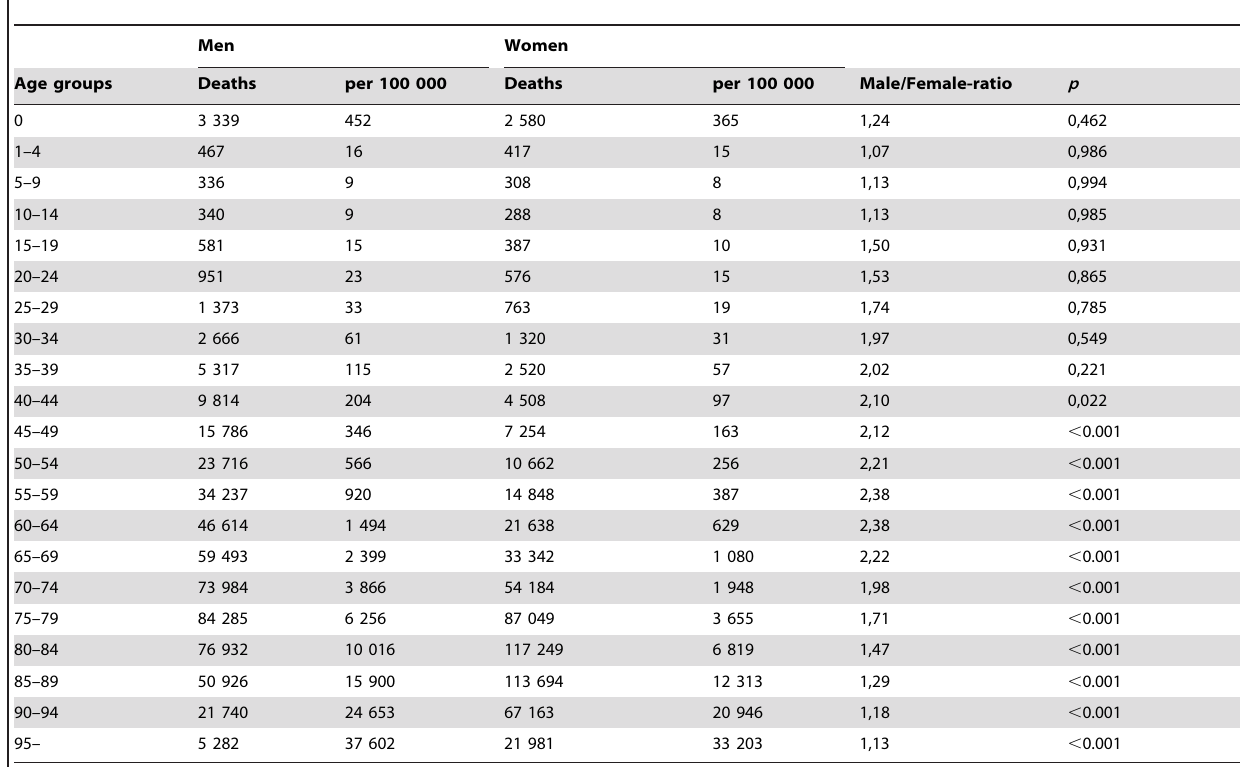
Table 2. Overall mortality among men and women by age, Finland